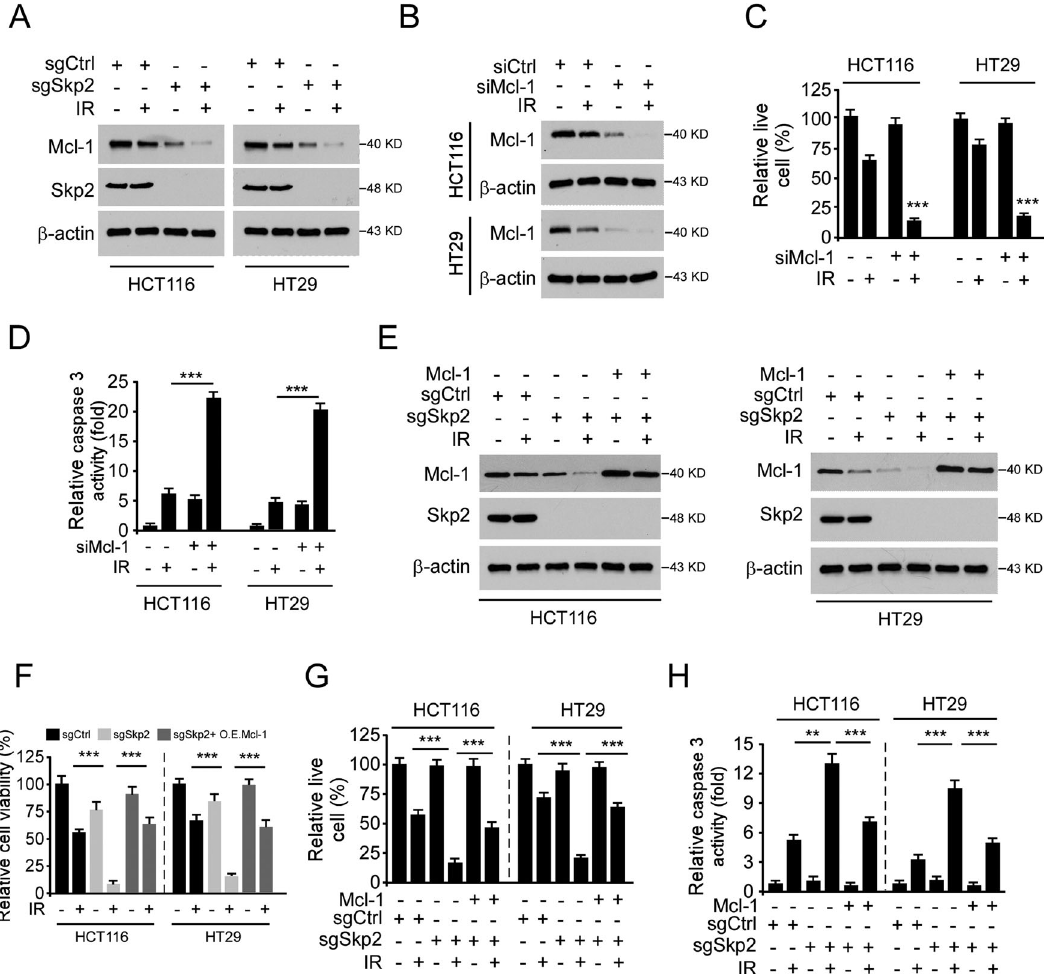
Fig. 3 Irradiation decreases Mcl-1 protein level. A Skp2 knockout CRC stable cells were treated with/without IR (2 Gy) and cultured for 72 h, WCE was subjected to IB analysis. B – D HCT116, and HT29 cells were transfected with siMcl-1 for 24 h, followed by IR (2 Gy) treated and cultured for 72 h. WCE was subjected to IB analysis ( B ). The live cell population was determined by trypan blue exclusion assay ( C ). Caspase 3 activity was examined by Caspase 3 Assay Kit ( D ). *** p < 0.001. E – H Mcl-1 was transiently transfected into Skp2 depleted HCT116 and HT29 cells using lipofectamine 2000 and maintained for 24 h. Cells were treated by IR (2 Gy) and cultured for 72 h. WCE was subjected to IB analysis ( E ). Cell viability and live cell population were determined by MTS assay ( F ) and trypan blue exclusion assay ( G ), respectively. Caspase 3 activity was examined by Caspase 3 Assay Kit ( H ). ** p < 0.01, *** p <